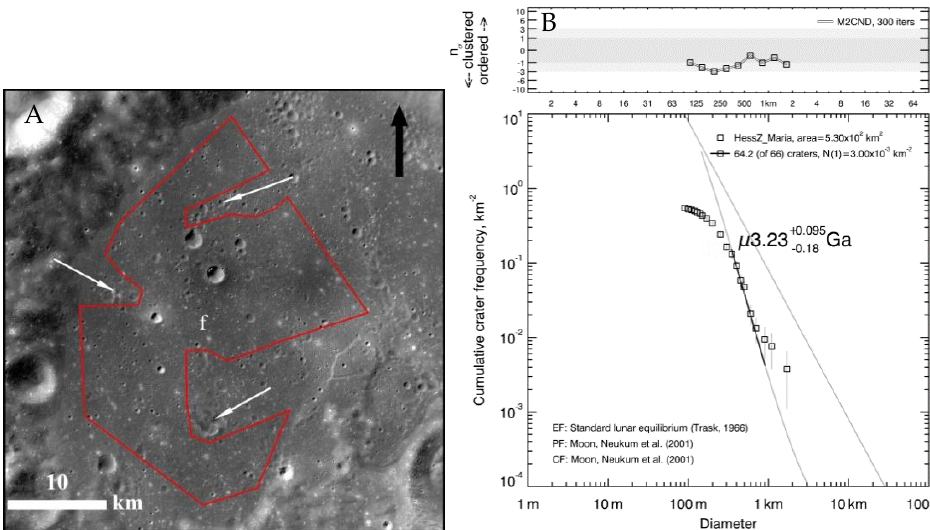
Figure 6. ( A ) CE-2 DOM mosaic of the mapped basalt unit in Hess Z crater (530 km 2 ) (central location: 173.49° E, 51.94° S); North is up. ( B ) derived AMA. The equilibrium function is the standard lunar equilibrium of [35], while both the production and chronology functions are from [36]. The red polygon in the left sub-figure is the outlined representative crater count area, and the arrows indicate the excluded secondary craters.